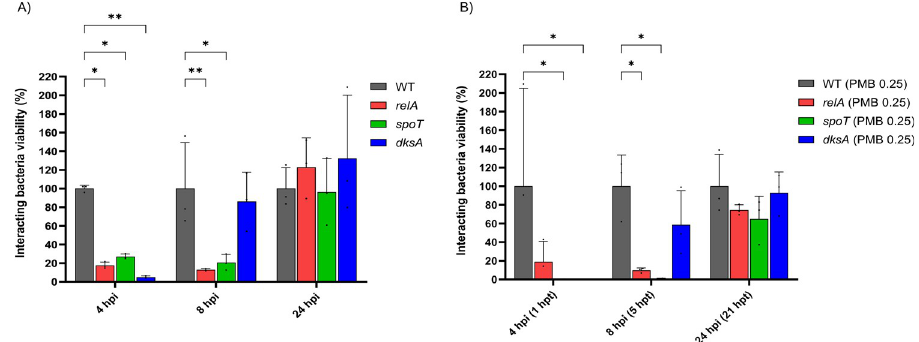
Fig 6. Impaired stringent response reduces interacting bacterial growth in the presence of THP-1-dMs. Interacting bacterial growth of AB5075 wild-type (WT) and transposon mutants with disrupted stringent response regulatory genes following MOI 1,000 infection of THP-1-dMs in the A ) absence and B ) presence of 0.25 mg/L polymyxin B (PMB) treatment. Data shown as mean ± SD of three biological replicates compared to that of the wild-type. Two-way ANOVA with Tukey’s HSD post-hoc test, � p < 0.05, �� p < 0.01.